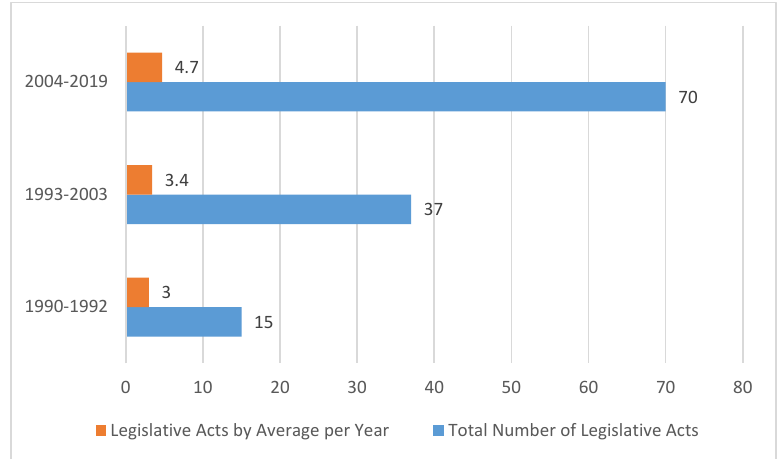
Fig. 3. Increasing number of all legislative acts (laws, government decree, public regulations)